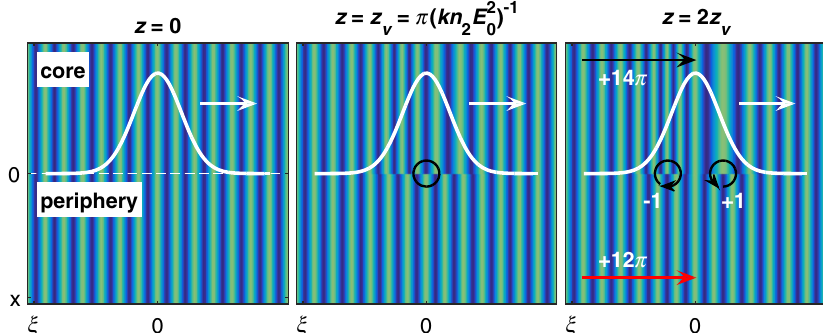
FIG. 2. Toy model showing birth of a vortex pair via spatiotemporal phase front shear. The white curve and arrow depicts the axial (temporal) intensity profile and propagation direction, while the “ core ” and “ periphery ” labels denote the spatial intensity step. The z ¼ 0 panel shows the initial condition where phases are aligned, the z ¼ z panel shows the birth of the null (vortices overlap), and the v z ¼ 2 z panel shows continued shear carrying the vortices apart, with the þ 1 vortex moving to the temporal front and the − 1 vortex v moving backward. Our phase winding convention considers a ð ξ − ξ 0 Þ þ i ð x − x 0 Þ winding about a null at ( ξ 0 , x 0 ) to denote a þ 1 STOV. In the third panel, red and black arrows indicate the direction of increasing phase. The two arrows connect the same lines of constant phase; the arrows show that the phase difference between head and tail is ill defined due to the vorticity of the − 1 STOV.